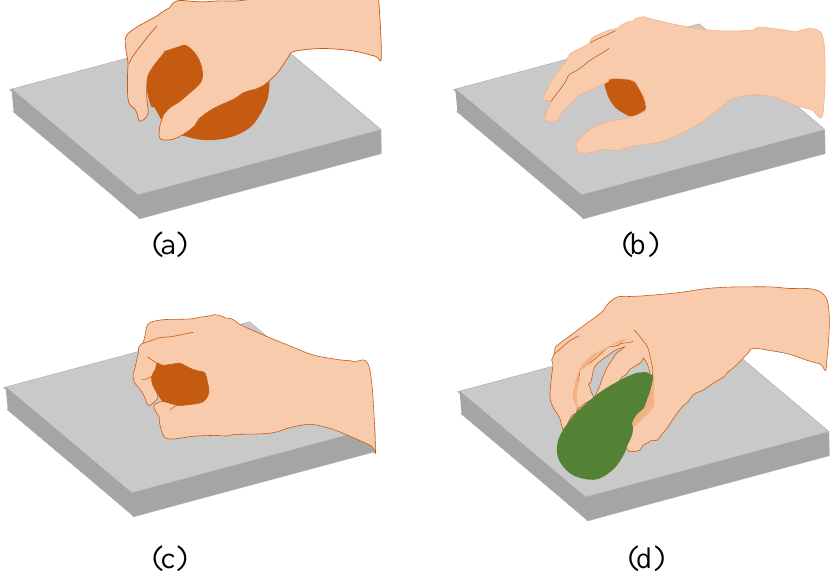
Figure 3. Typical hand grasping posture. ( a ) The palm-aligned power grasping. ( b ) The palm- aligned grasping for small diameter objects. ( c ) The proximal phalanx-aligned grasping. ( d ) The precision grasping.